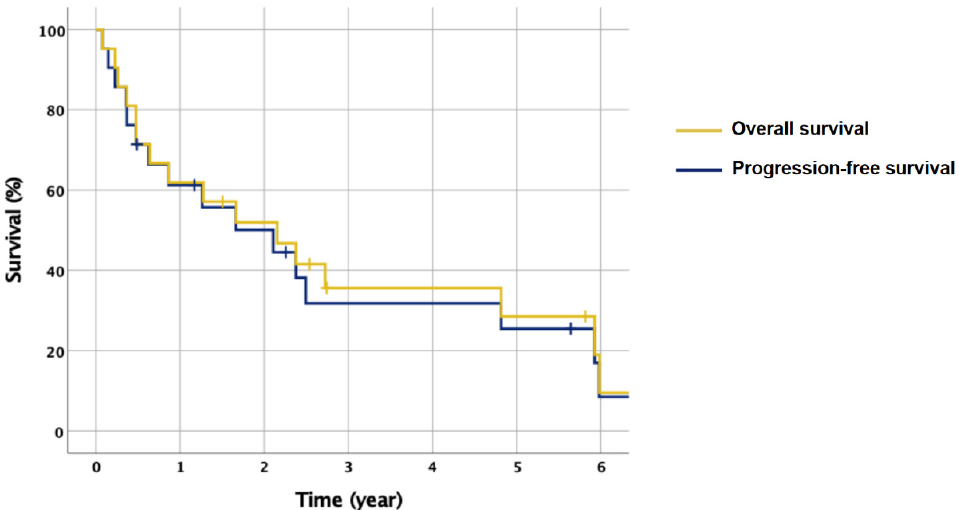
Figure 3. Kaplan – Meier survival curves for patients treated with cranial radiation therapy. Median